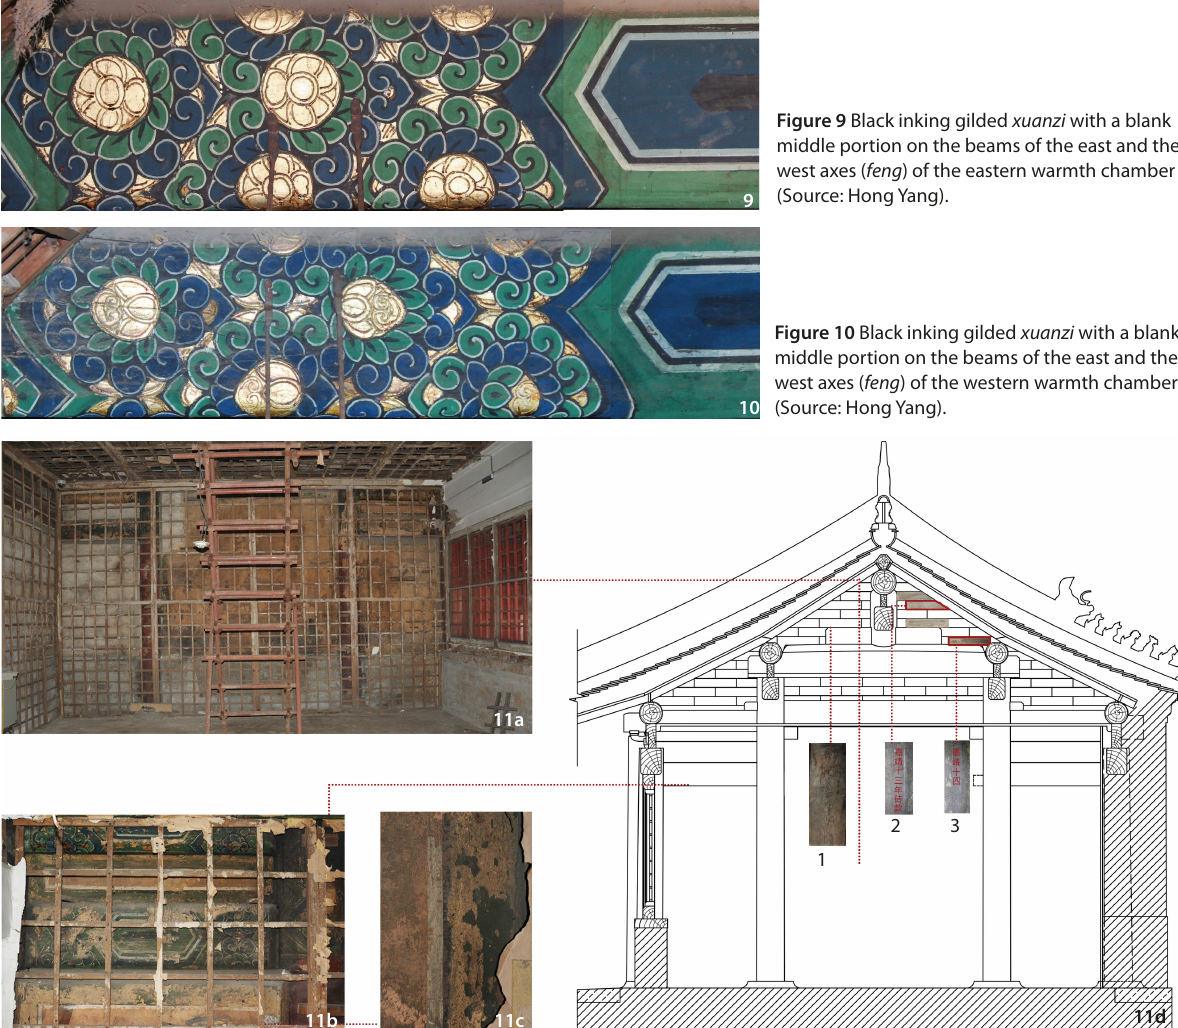
Figure 9 Black inking gilded xuanzi with a blank middle portion on the beams of the east and the west axes ( feng ) of the eastern warmth chamber (Source: Hong Yang).